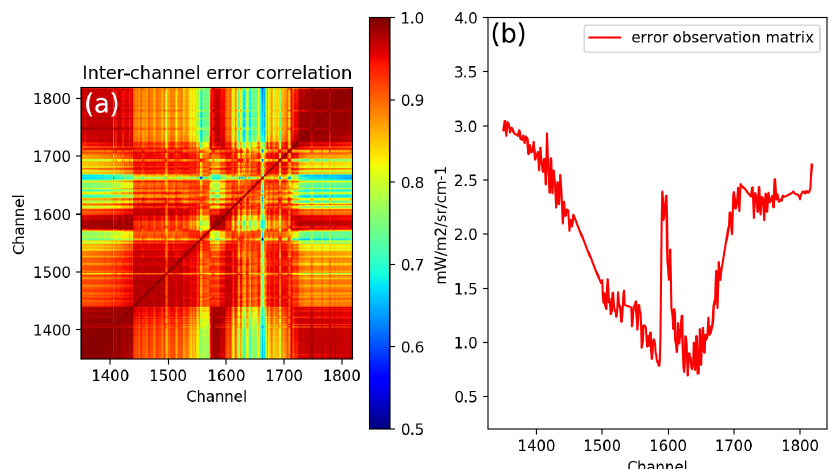
Figure 1. Observation error covariance used to assimilate IASI L1 radiances in this study: correlation matrix (a) and error standard deviation (squared diagonal of the covariance matrix, b ). The x and y axes in panel (a) and the x axis in panel (b) report the IASI spectral channel’s number within the 980–1100cm − 1